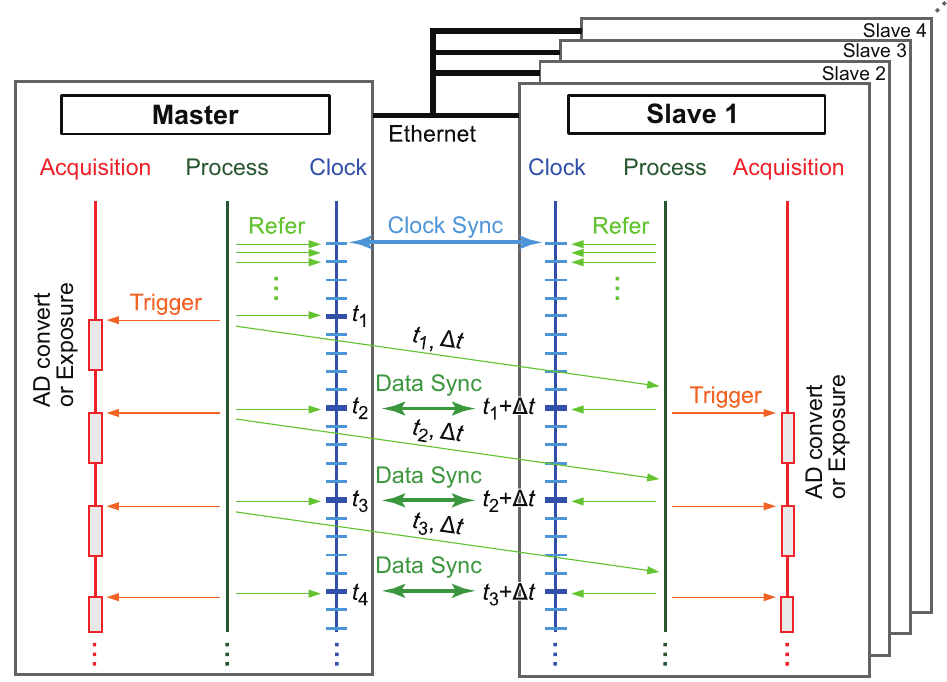
Figure 1. Proposed method for synchronizing data-acquisition timing based on clock synchronization. Adapted from